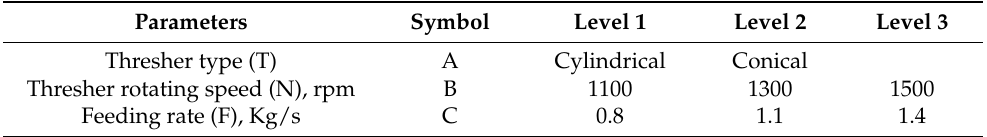
Table 3. Threshing parameters levels.